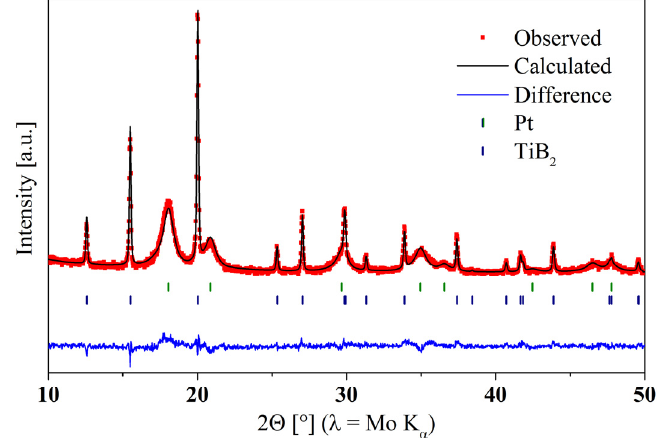
Figure 1. X-ray diffraction pattern of Pt nanoparticles supported on TiB data and Rietveld refinement are shown. Sharp reflections belong to the support material, broad reflections can be attributed to the Pt nanoparticles. The Pt nanoparticle size is ≈ 5 nm.